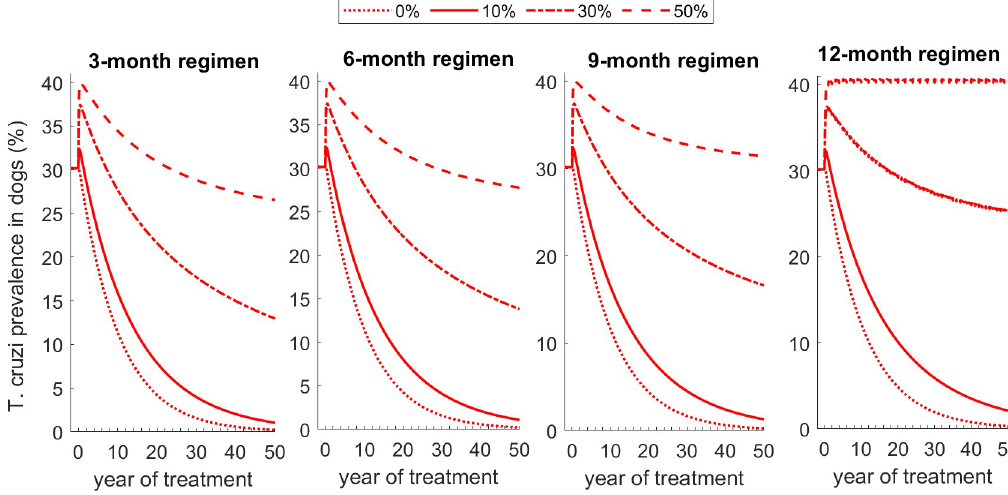
Fig 10. Impact of increased consumption of dead triatomines by dogs on the effectiveness of fluralaner treatment regimens for reducing dog T . cruzi prevalence. We consider four scenarios: 1) no increased consumption of dead bugs, 2) 10% of bugs killed by fluralaner treatment are eaten by dogs, and 3) 30% of bugs killed by fluralaner treatment are eaten by dogs, and 4) 50% of bugs killed by fluralaner treatment are eaten by